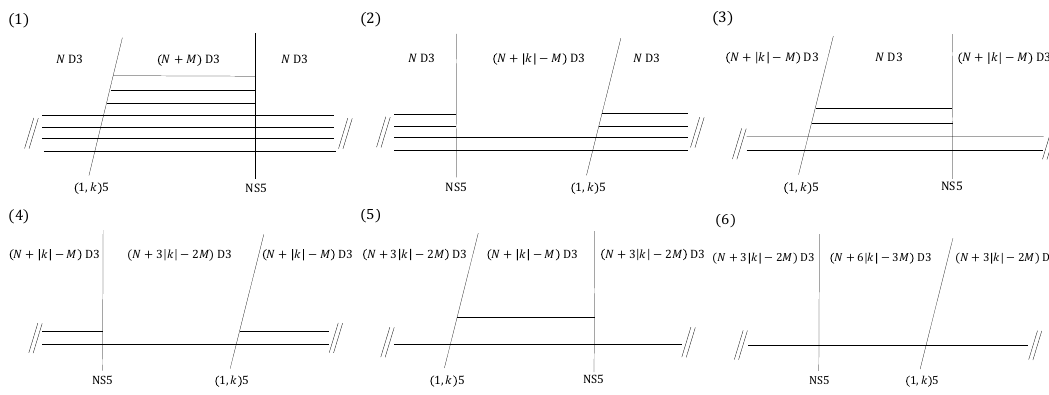
U( N + M ) theory with k × − k